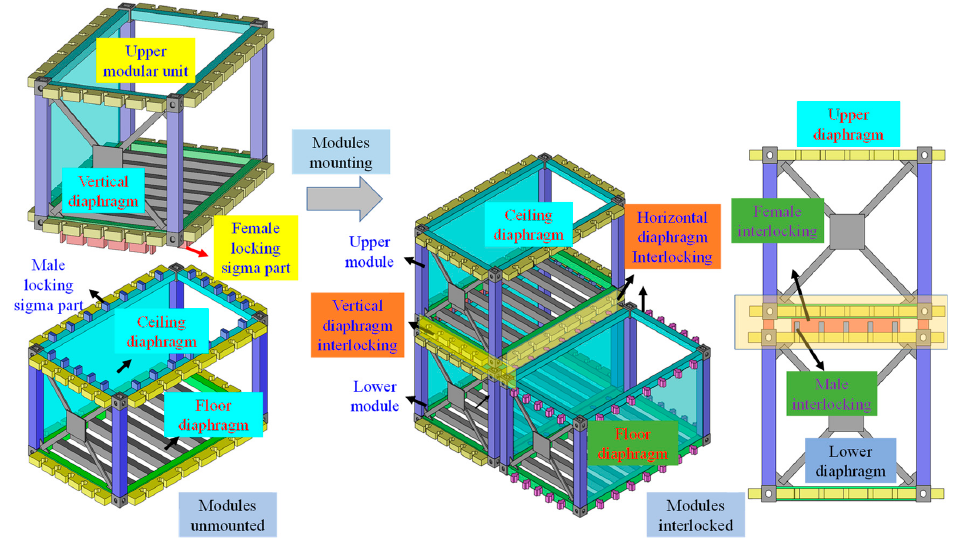
Figure 10. Self-locking automatic vertical beam-to-beam IMC.